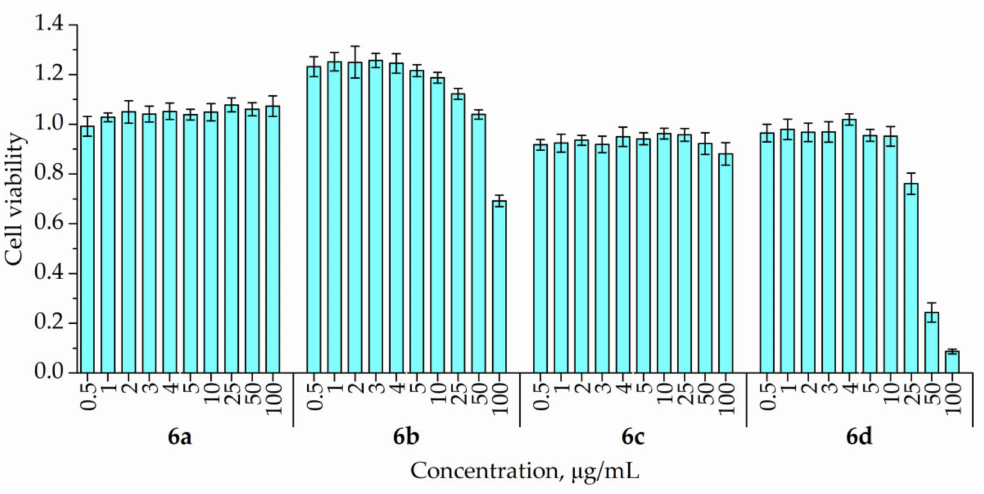
Figure 2. Cytotoxicity of compounds 6a – d on cell line A549